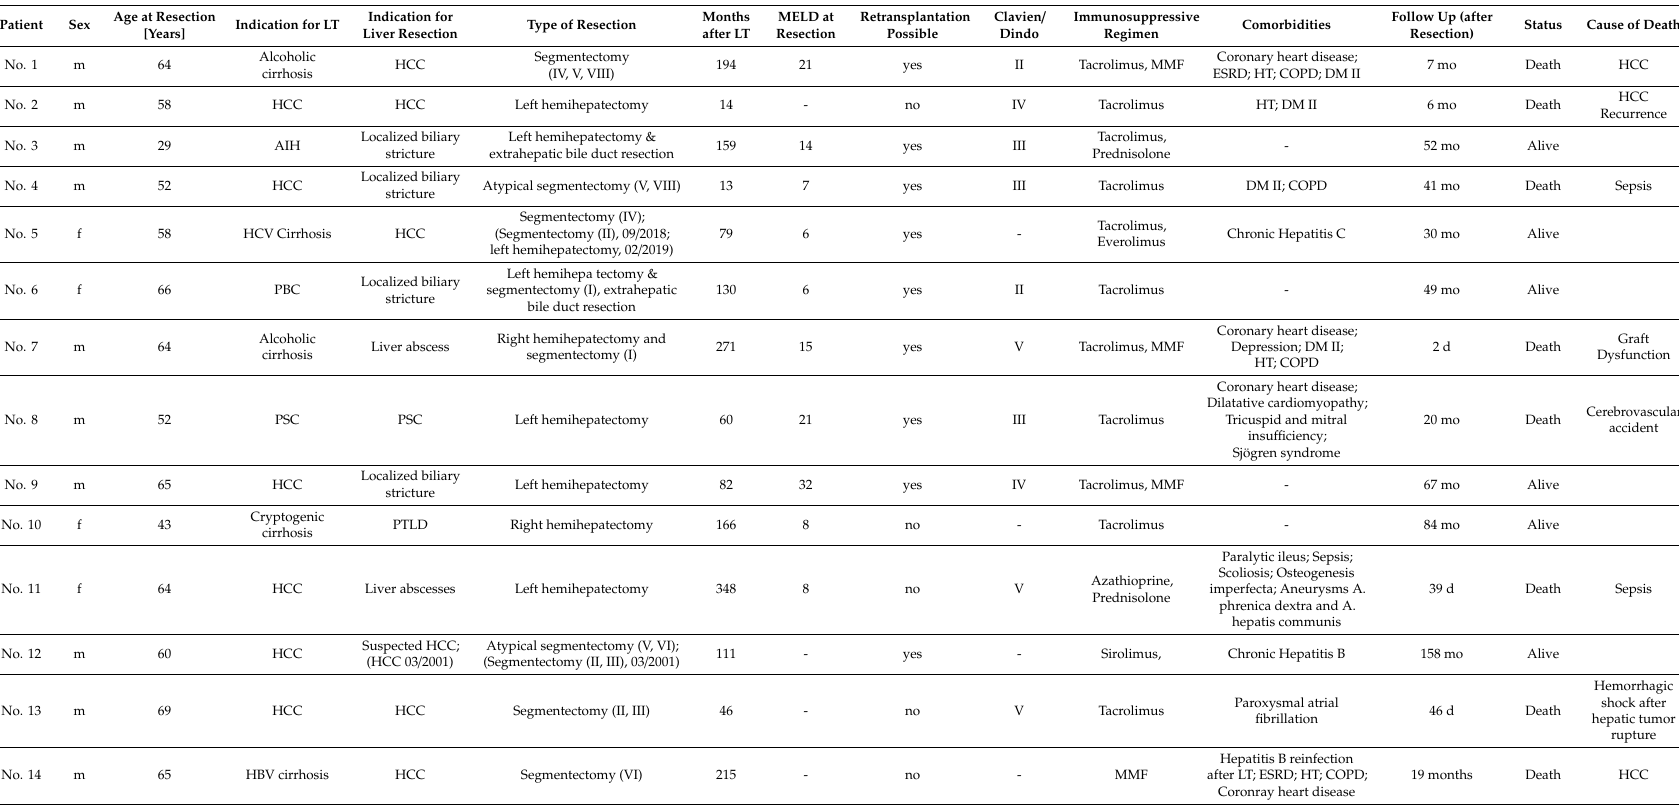
Table 2. Individual Characteristics of Patients Undergoing Liver Resection after Liver Transplantation.